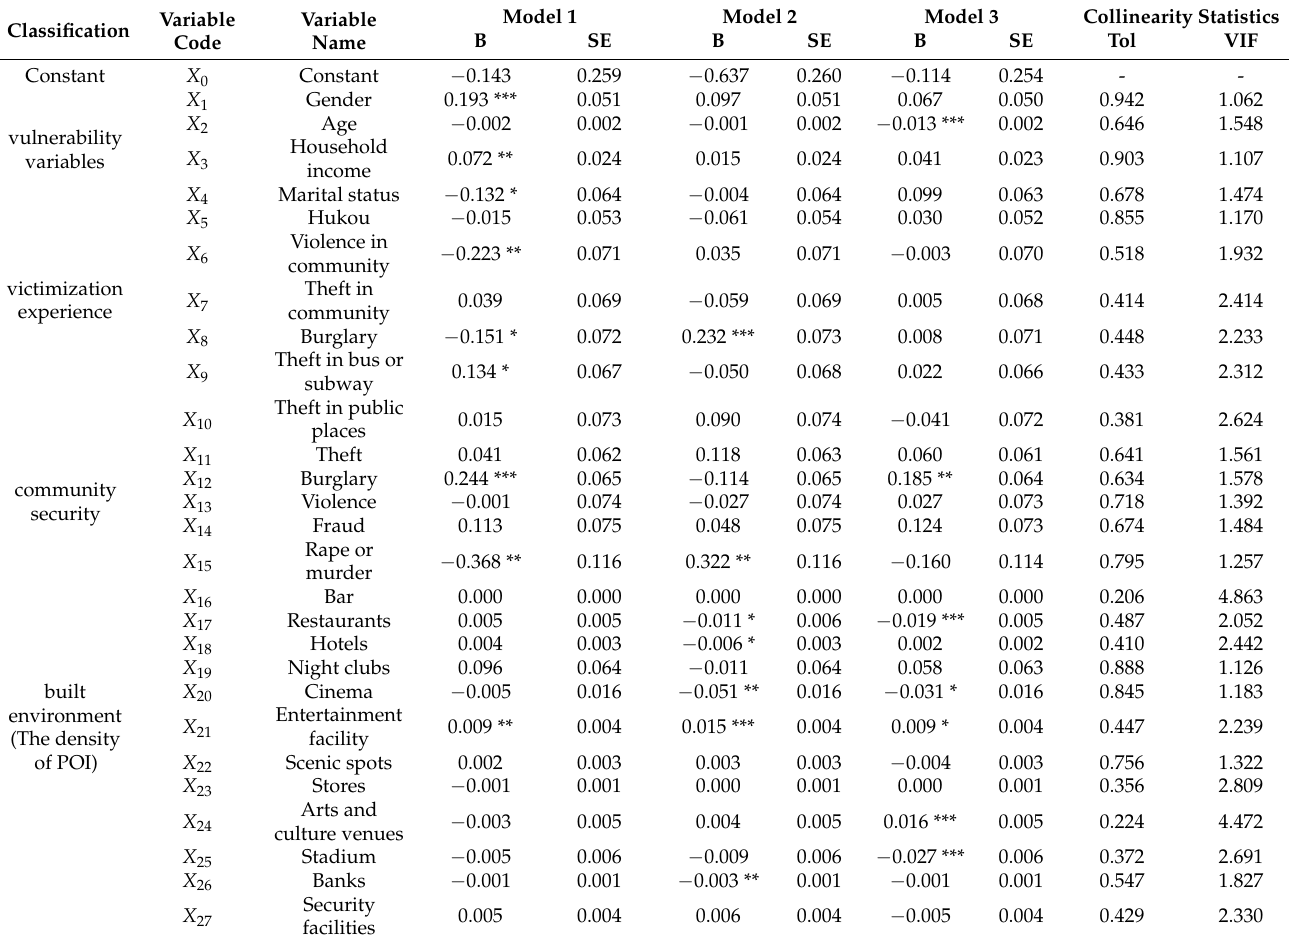
Table 3. Regression models for fear of theft in different